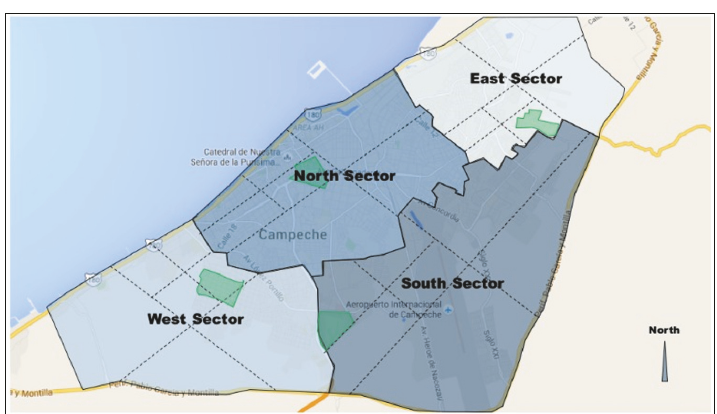
Figure 1: The city of San Francisco de Campeche divided into 4 sectors (North, South, East, and West); each sector divided into four from where a quadrant (in green colour) was selected and walked in foot.